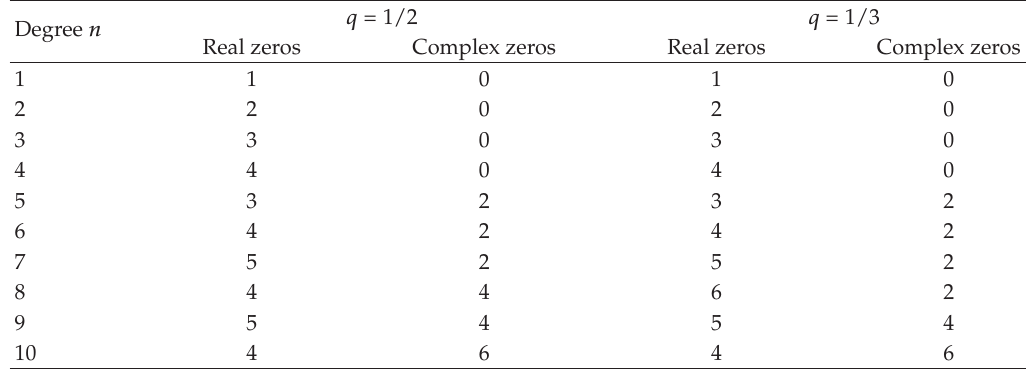
Table 1: Numbers of real and complex zeros of G n,q (cid:2) x (cid:3) .